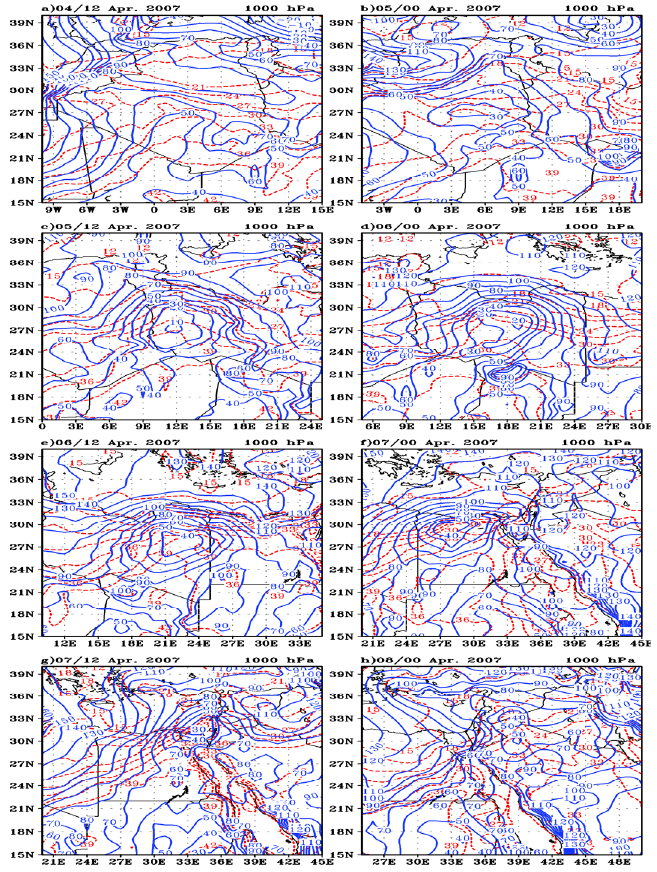
Figure 2. 1000 hPa geopotential height contours at every 10 gpm interval (blue solid) and temperature (red dashed) every 3 °C at 12Z and 00Z for 4–8 April 2007.